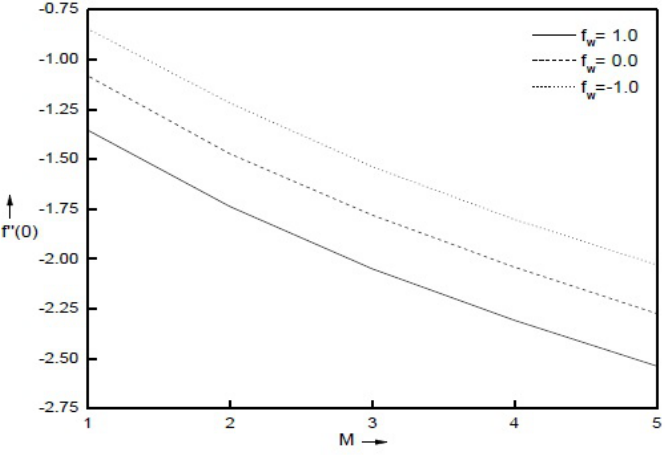
Fig. 7 Variation of f (cid:48)(cid:48) ( 0 ) with M for various values of porosity parameters f w